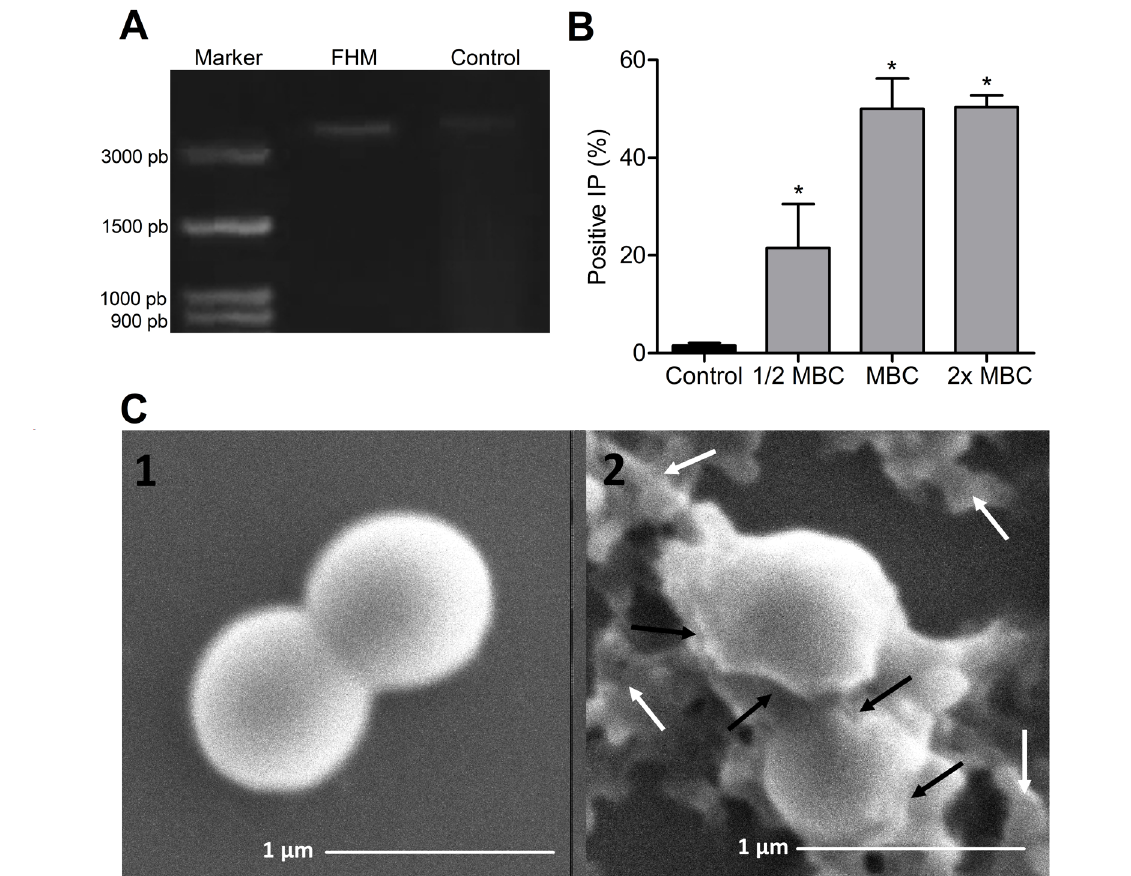
FIGURE 2 – Effects caused in S. aureus treated with hidromethanolic fraction (FHM) from P. spruceanum leaves. Analysis of bacterial DNA using 1.8% agarose gel electrophoresis (A), membrane permeability by proppidium iodide, where *p<0.05 versus control (B) and cell shape by scanning electronic microscopy (20000x, SS20), where white arrows indicate FHM precipitated and black arrows indicate cell surface deformations